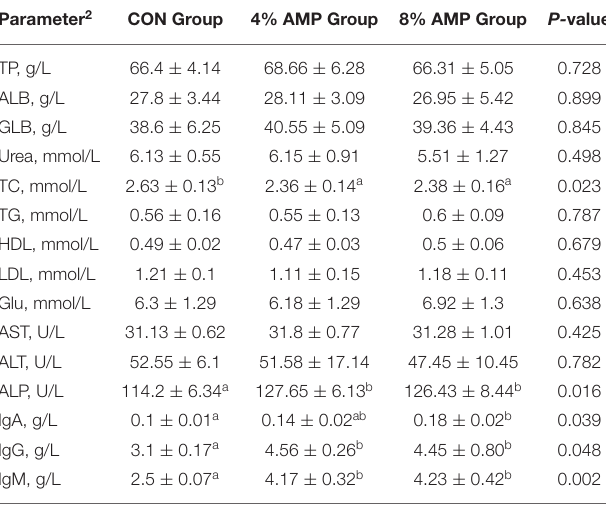
TABLE 4 | Effect of dietary AMP supplementation on serum biochemical indicators of pigs 1 . Parameter 2